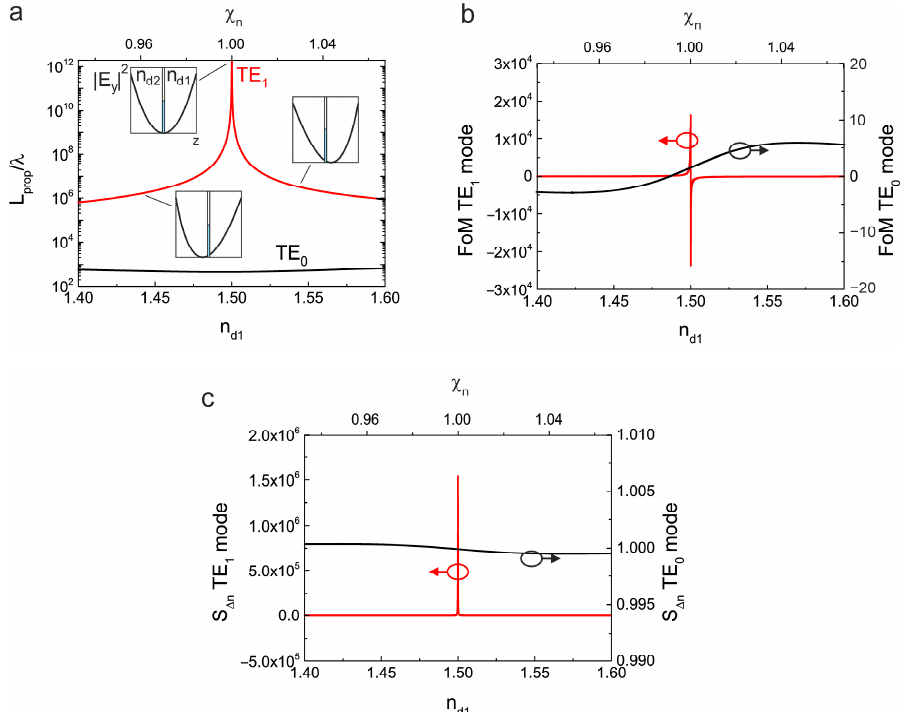
Figure 6. ( a ) The normalized propagation length, ( b ) FoM , and ( c ) S ∆ n of a waveguide grating with t g = 1.5 × 10 − 3 λ and otherwise identical parameters to the ones in Figures 3 and 4 with asymmetric refractive index changes ( 𝑛 (cid:3031)(cid:2869) is varied, and 𝑛 (cid:3031)(cid:2870) is fixed at a value of 1.5). However, for the 𝑇𝐸 (cid:2869) mode, it can be observed that 𝑆 ∆(cid:3041) exhibits a maximum at 𝜒 (cid:3041) = 1.0 , with a substantially higher value of around 1.5 × 10 (cid:2874) , in comparison to the 𝑇𝐸 (cid:2868)